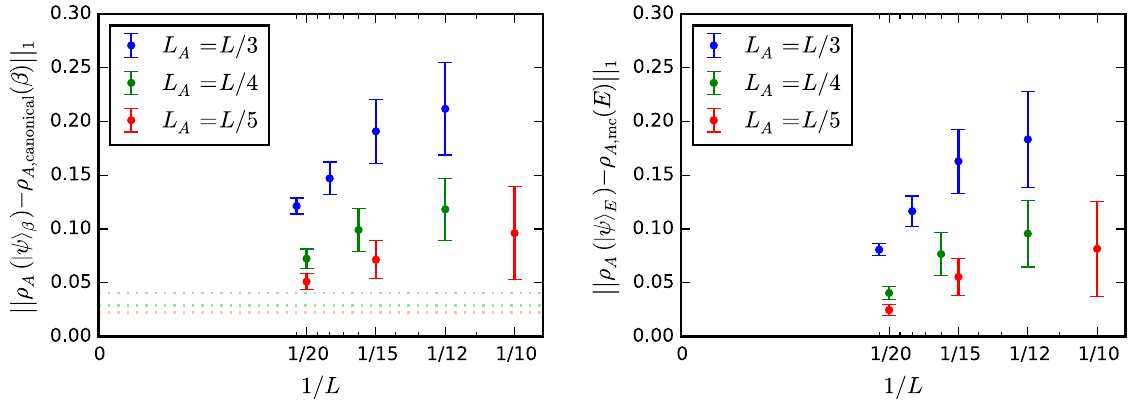
FIG. 12. Left panel: Trace norm distance between the reduced density matrices as a result of a single eigenstate and the canonical =L and 0 . 28 < β < 0 . 32 . As in Fig. 10, the error bars represent one standard deviation away from the ensemble for constant ratio L A mean. The horizontal lines indicate the approximate theoretical minimum each trace norm distance can take, based on the suppressed energy variance given by maximizing Eq. (42). Right panel: Trace norm distance between the reduced density matrices from a single =L , considering all eigenstates in the range 0 . 28 < β < 0 . 32 . As in eigenstate and a microcanonical ensemble for constant ratio L A Fig. 8, the microcanonical ensemble is defined as the equal mixture of 50 eigenstates nearest in energy to the one under